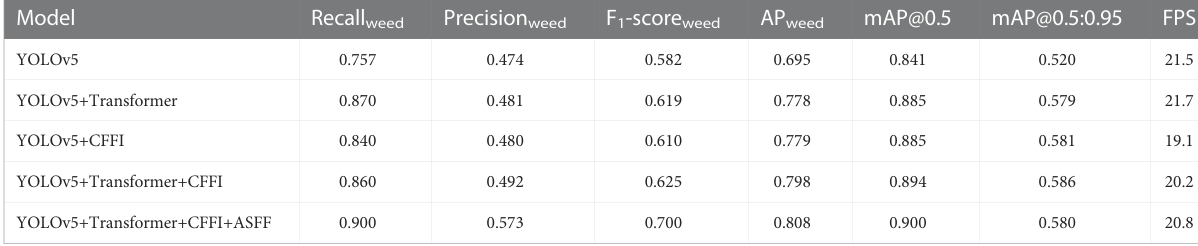
TABLE 1 Ablation study on the effect of different modules of the proposed TIA-YOLOv5 network.